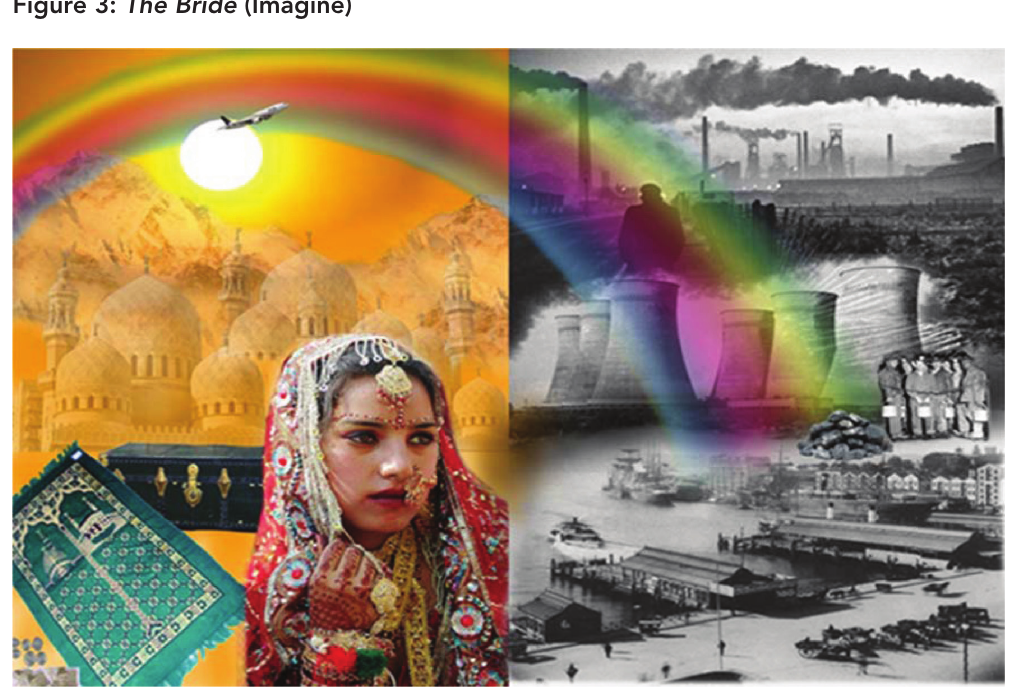
Figure 3: The Bride